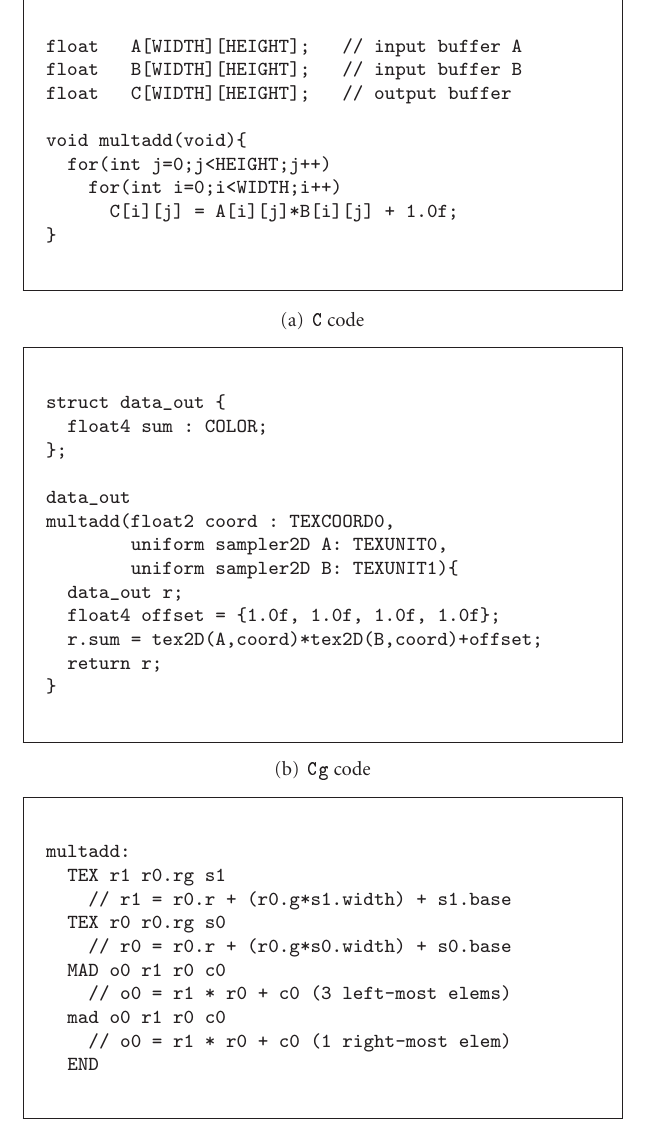
Figure 2(c) shows the resulting CTM code from the example shader program in Figure 2(b). From left to